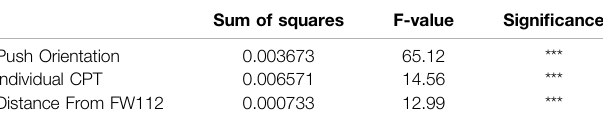
TABLE 3 | ANOVA test of changes in hydraulic head (m) based on the distance and orientation of each push from FW112. Sum of squares Push Orientation